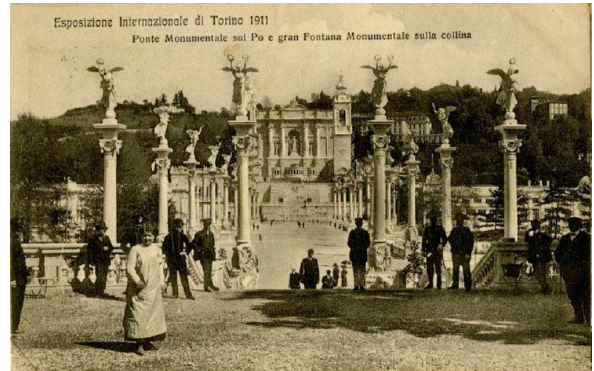
Figure 4. 1911 Postcard of the Monumental Bridge with the Courtyard of Honour and the Monumental Waterfall in the background (CDC private collection)